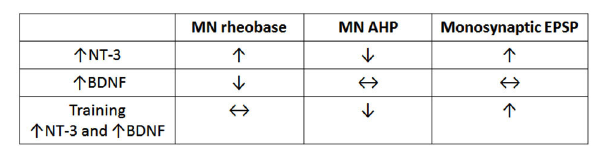
FIGURE 1 | Comparison of effects of NT-3, BDNF and step training on electrophysiological properties of motor neurons . Note that training gives results that are qualitatively equivalent to the sum of the separate effects of NT-3 (data row 1) and BDNF (data row 2). The data are derived from Petruska et al. (2007), Petruska et al. (2010) and Boyce et al.